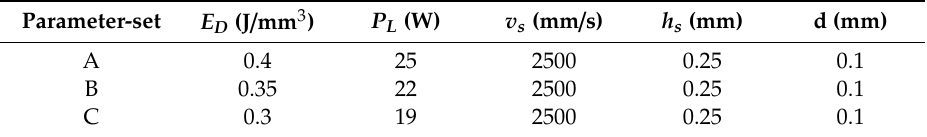
Table 3. LS system parameter. Table 3 . LS system parameter.